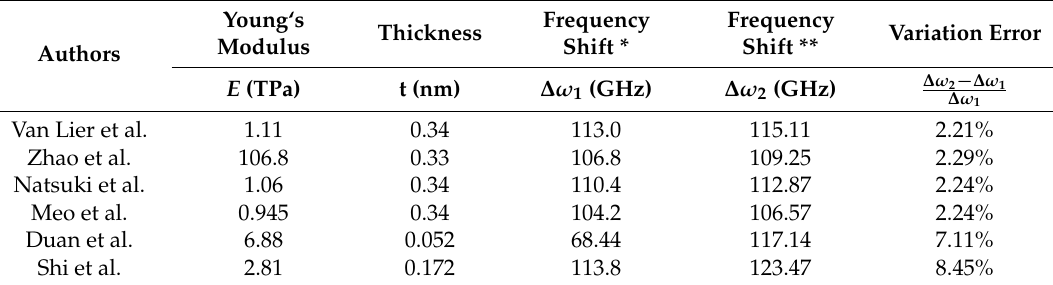
Table 1. Young’s modulus, thickness and the frequency shifts of GSs